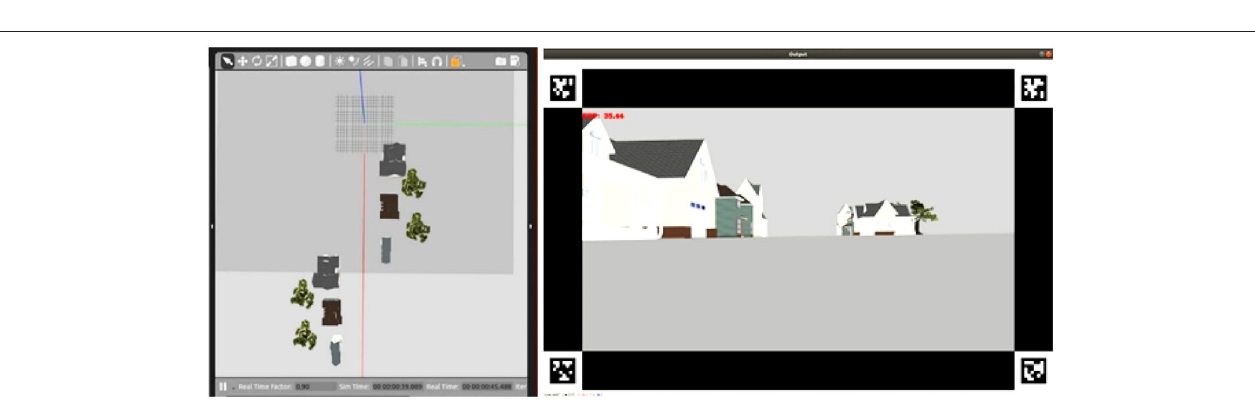
FIGURE 6 | Left : Anafi Parrot drone. Right : a snapshot of the rendering of the Parrot Sphinx simulator used in the experiments.